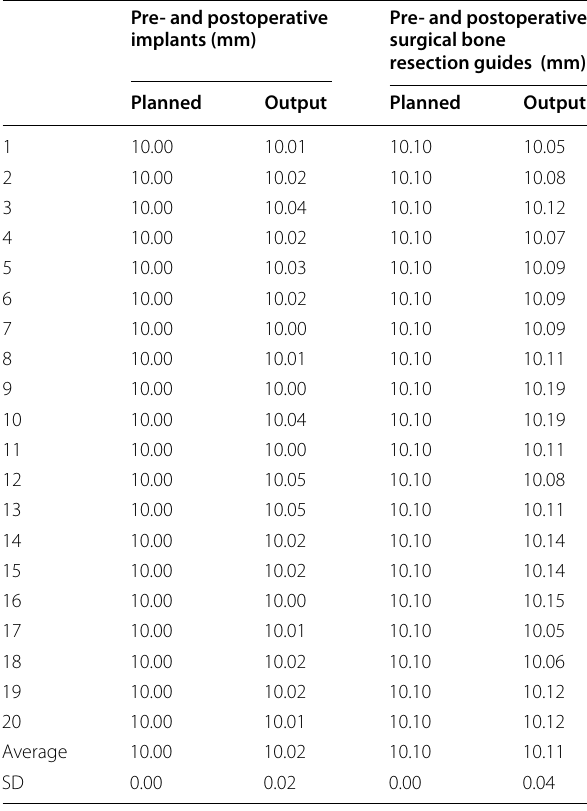
Table 1 Accuracy of printed implants and surgical bone resection guides